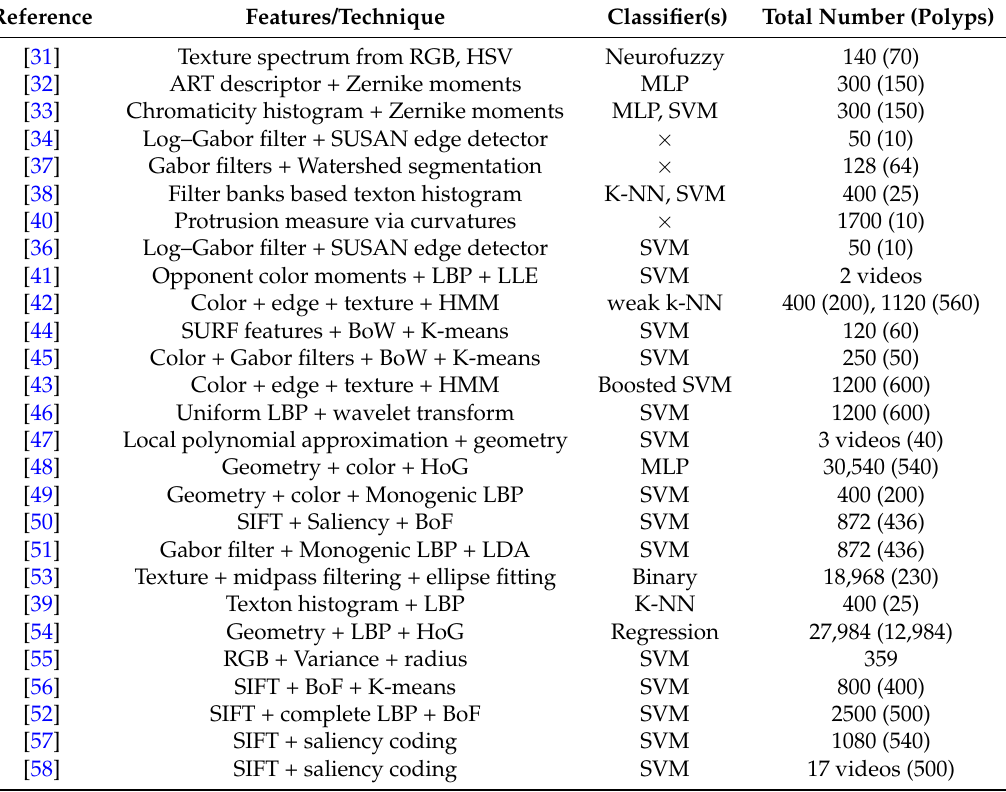
Table 1. Overview of automatic polyp detection methods in video capsule endoscopy (VCE) with salient techniques, classifiers, and total number of frames in VCE videos with polyp frames. Abbreviations: ART—angular radial transform, BoW—bag of words, BoF—bag of features, HMM—hidden Markov model, SIFT—scale invariant feature transform, SURF—speeded up robust features, HoG—histogram of oriented gradients, LLE—locally linear embedding, LBP—local binary patterns, K-NN—k-nearest neighbors, MLP—multilayer perceptron, SVM—support vector machines, LDA—linear discriminant analysis, × —no classifier